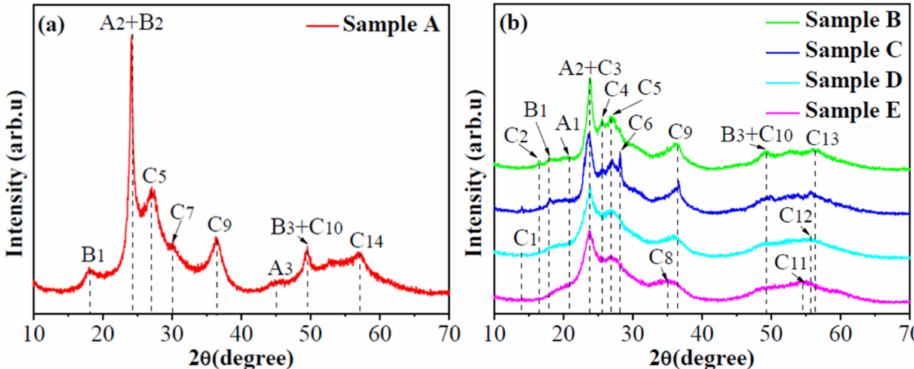
Figure 1. XRD patterns of as-synthesized WO 3- x aggregates of ( a ) sample A and ( b ) samples B–E respectively, which indicate that they are composed of mixed